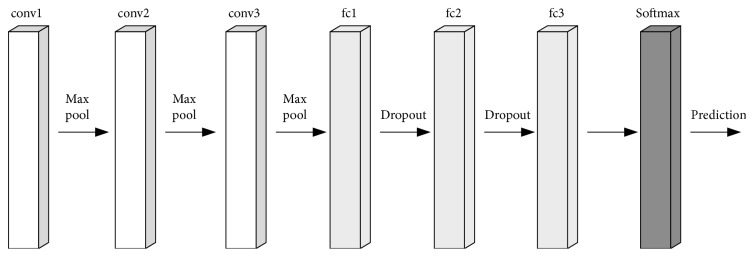
MKNet structure.